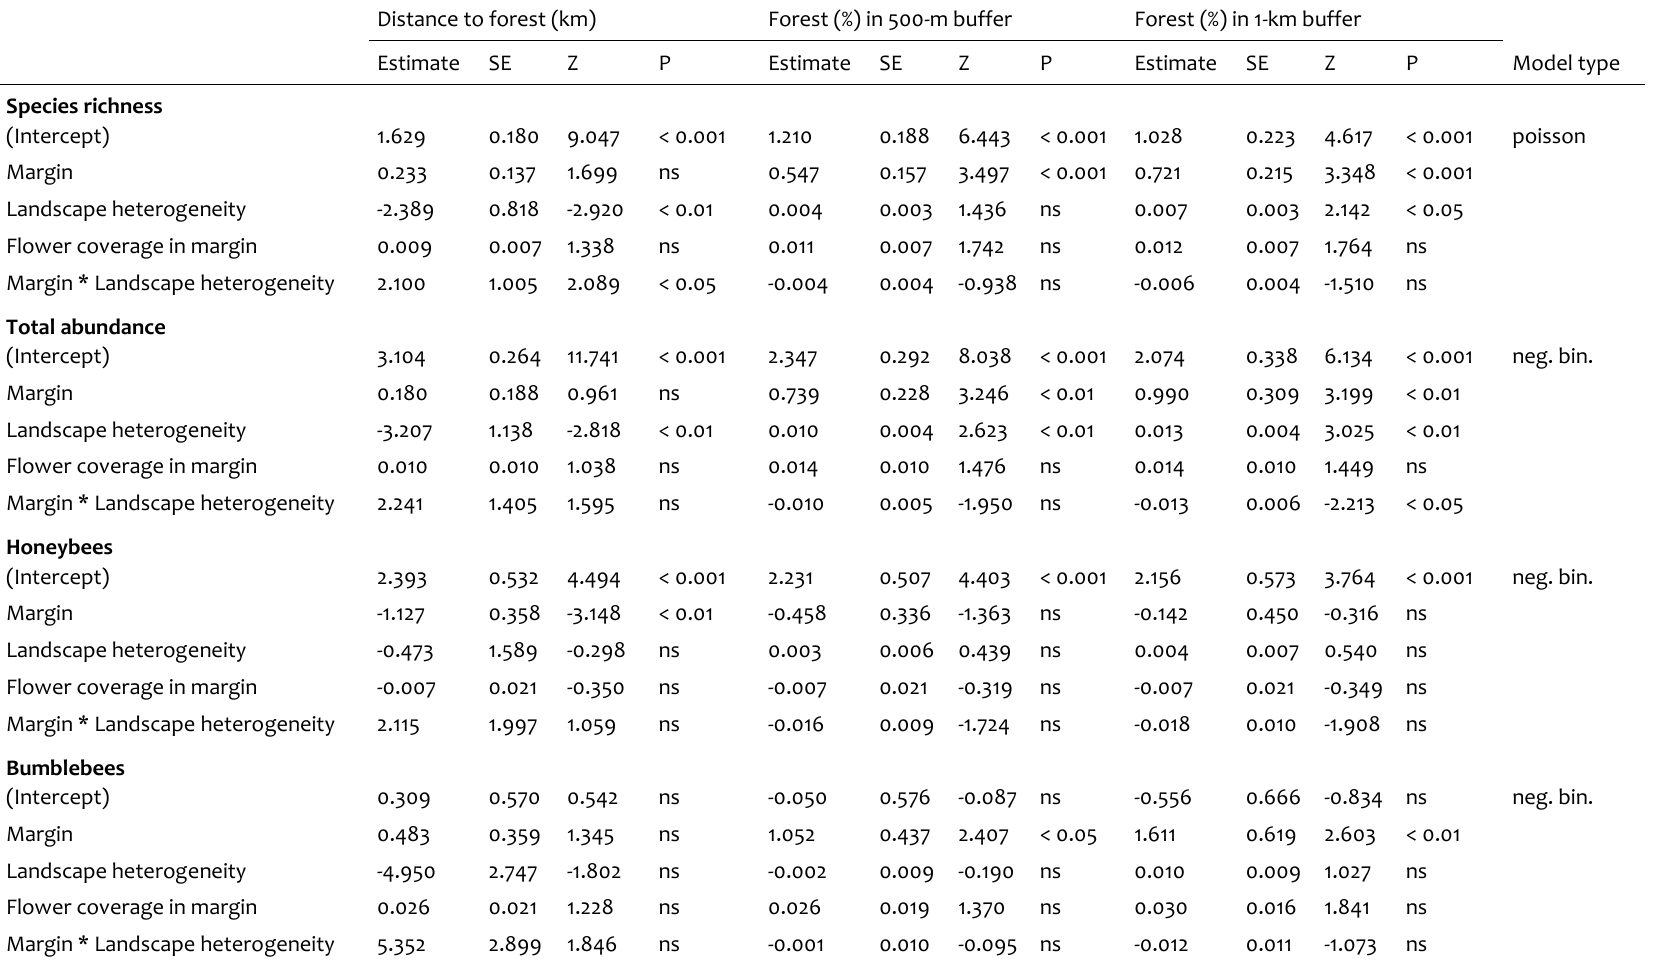
Table 2. Generalised linear mixed model results of the interactive effects of habitat type (field vs. margin) and landscape heterogeneity (distance to forest, forest cover within the 500-m buffer, or forest cover within the 1-km buffer) on species richness, total pollinator abundance, and abundances of five pollinator